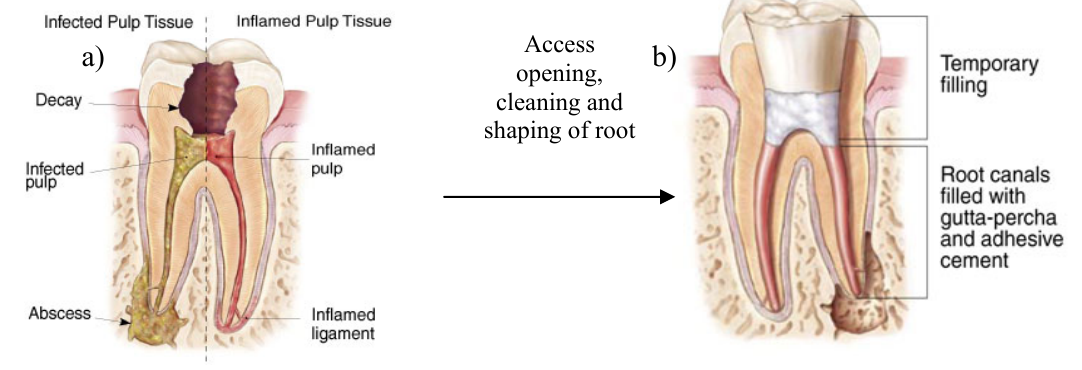
Figure 2. Inflammation and infection of pulp tissue ( a ) and example of completed root canal treatment. The temporary filling is placed into the empty pulp chamber; ( b ) Adapted from